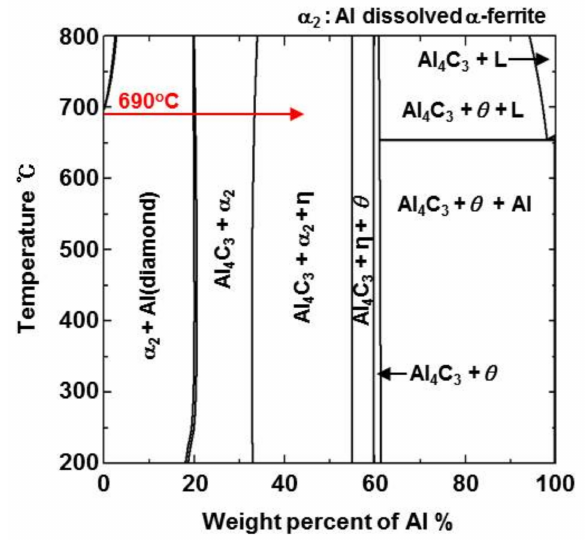
Figure 17. Steel- x Al quasi-binary phase diagram calculated using the Thermo-Calc. software ( α 2 : Al dissolved α -ferrite. Al: